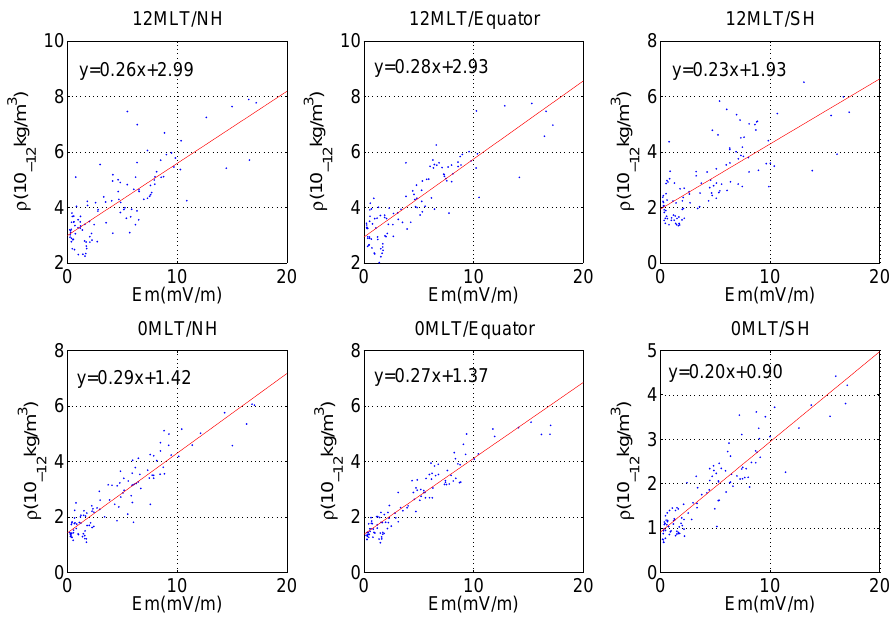
Fig. 5. The scatter plots of density versus E m for the 6 latitude bins for the storm 22–28 July 2004. The top panels are for the day-side (12:00MLT) and the bottom panels for the night-side (00:00MLT). From left to right, the three columns are for the northern mid latitude, low latitude and southern mid latitude, respectively. A linear fitting is shown by the red straight line in each panel, with the fitting equation at the top left corner.